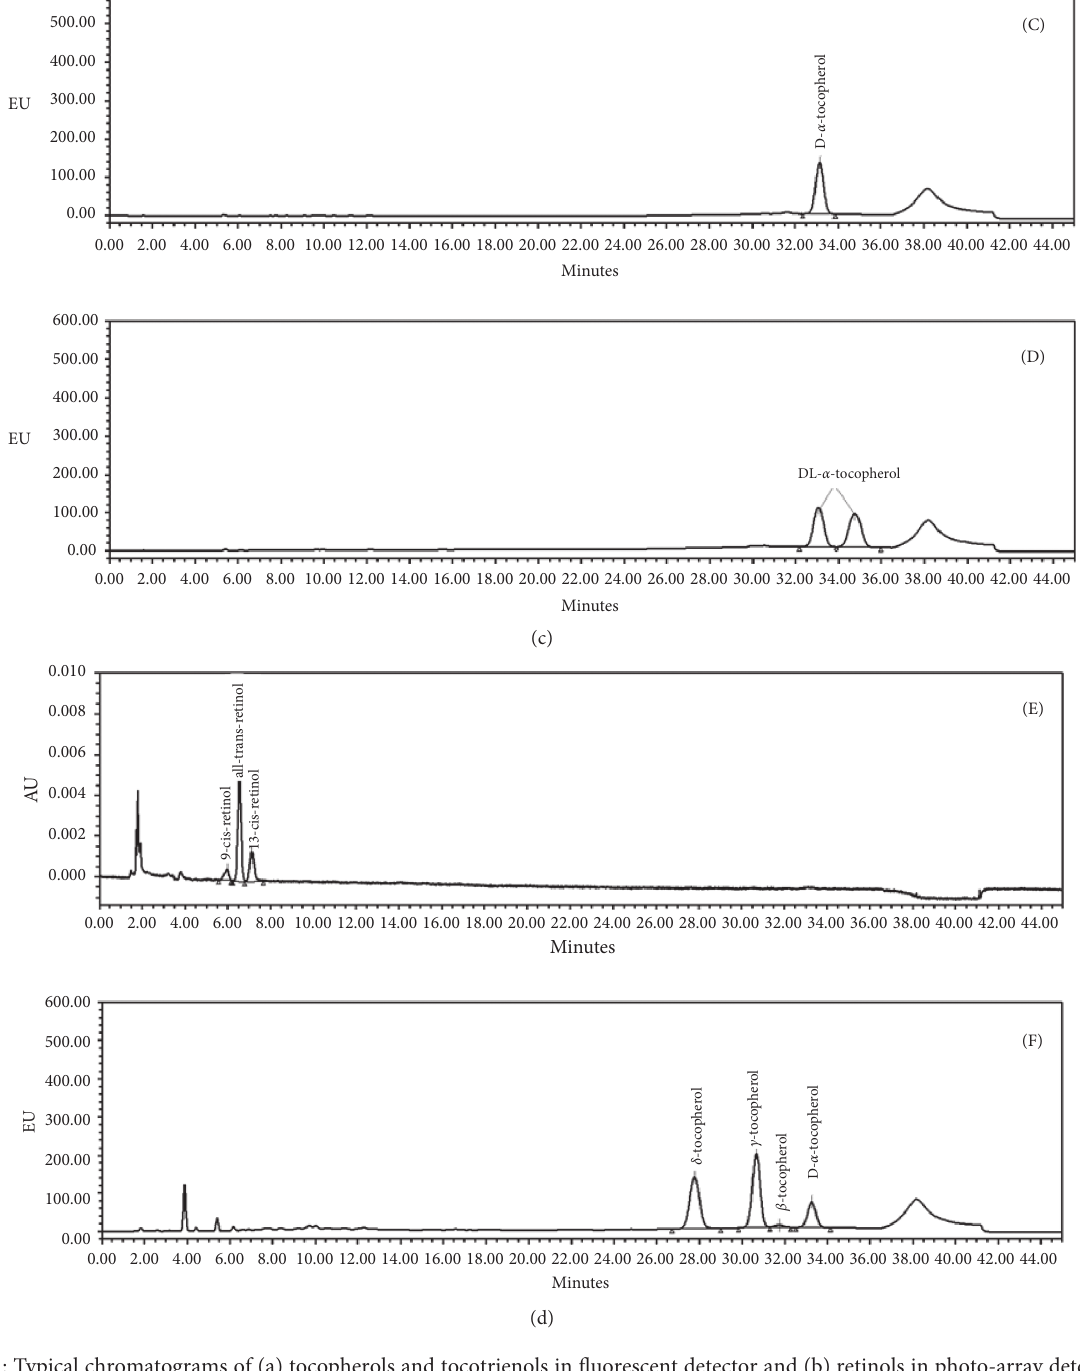
Figure 1: Typical chromatograms of (a) tocopherols and tocotrienols in fluorescent detector and (b) retinols in photo-array detector: (A) presents all analytes in mixture standard solution, (B) presents analytes in matrix extraction, (c) presents peaks of D- α -tocopherol (C) and DL- α -tocopherol (D) in the relative standard solution, (d) presents chromatograms of components in SRM 1849a, (E) retinols in photo- array detector, (F) tocopherols and tocotrienols in fluorescent